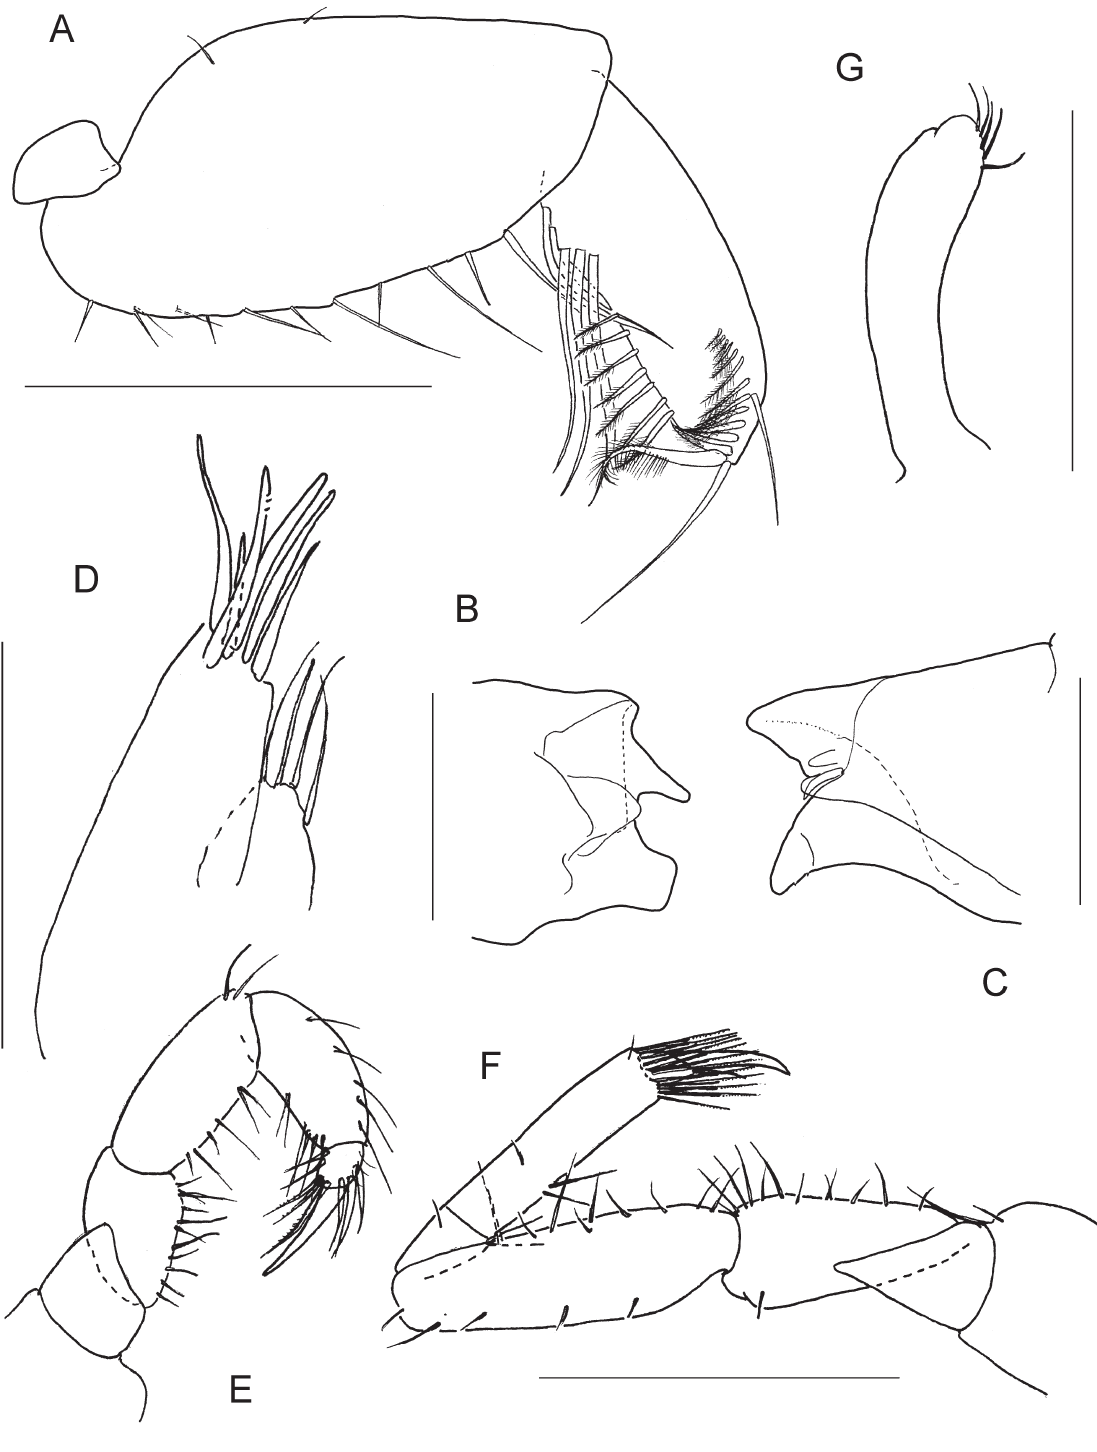
Fig. 27. Siriella talbotae sp. nov., holotype, ♂, length 5 mm, Lizard Island, Queensland, Australia. A . Mandibular palp, lateral view. B . Right mandible. C . Left mandible. D . Maxilla 1, anterior view. E . Endopod of maxilliped 2, posterior view. F . Endopod of pereopod 1, posterior view. G . Penis. Scale bars: A–D = 0.25 mm; E–G = 0.5